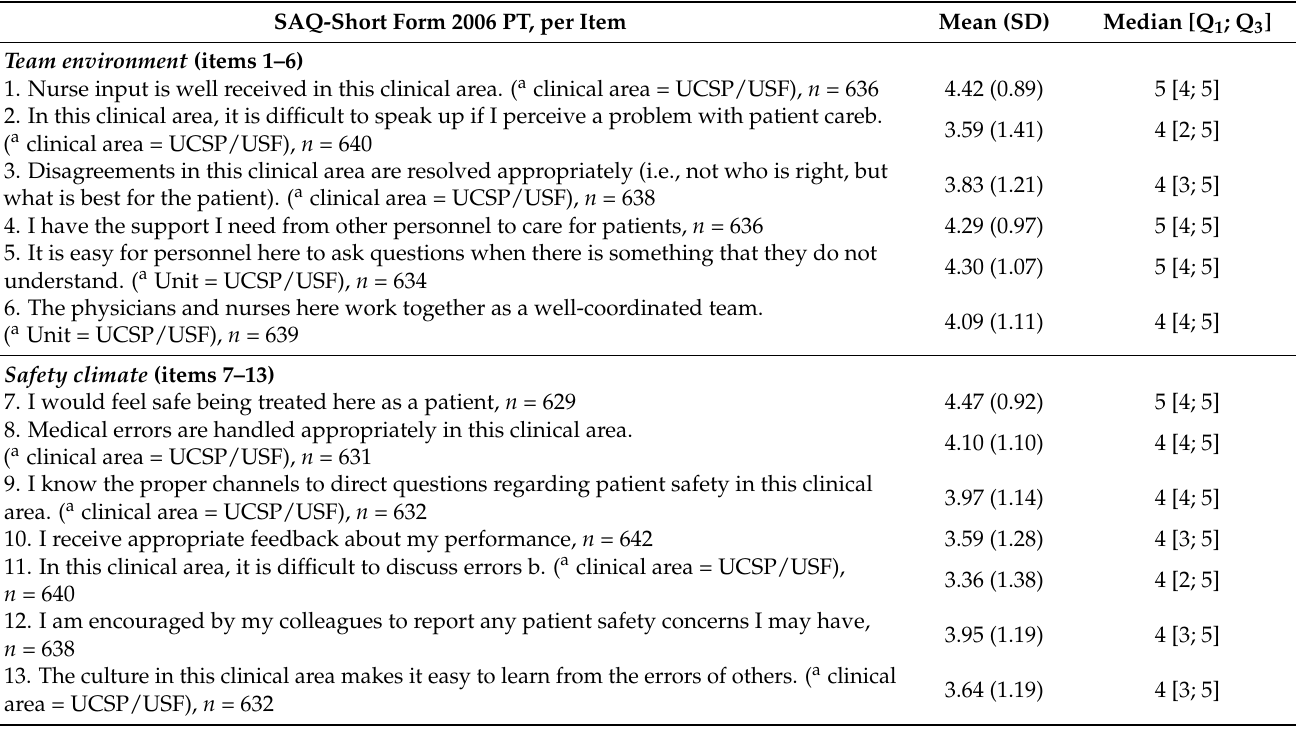
Table 3. Descriptive analysis of the SAQ—Short Form 2006 PT: mean (SD); median [Q 1 ; Q 3 ] per item. SAQ-Short Form 2006 PT, per